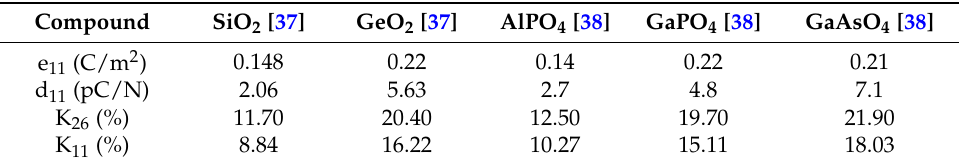
Table 2. DFT calculated piezoelectric constants and coupling factors K 11 and K 26